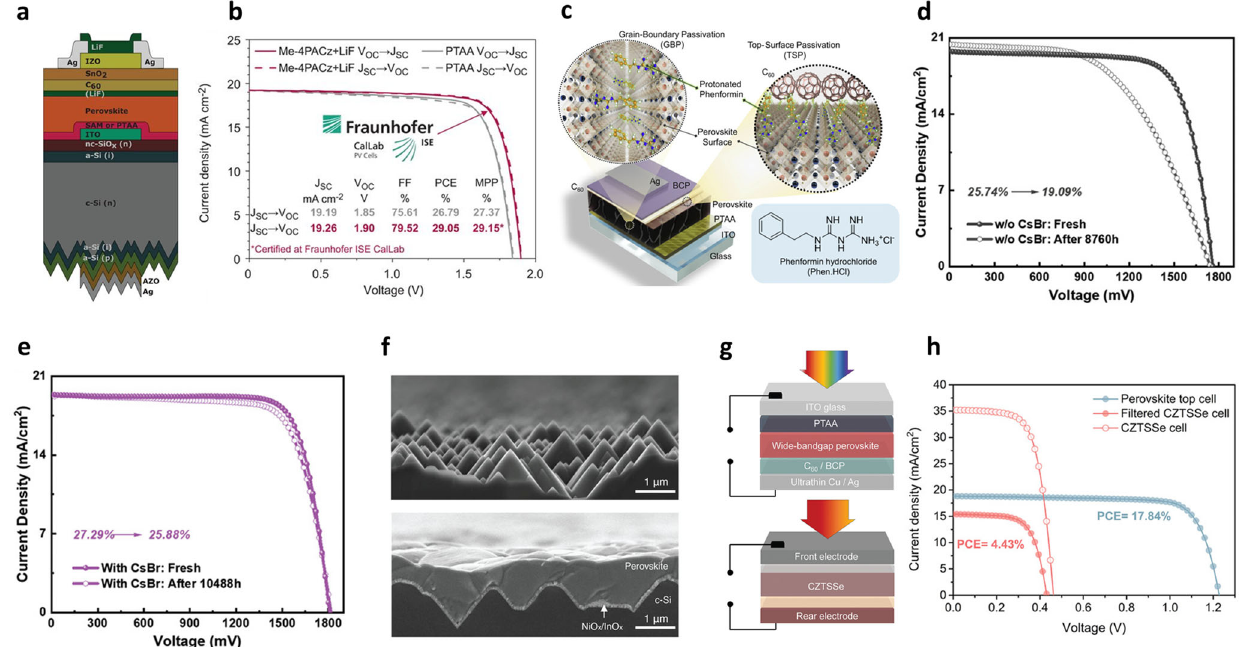
Fig. 4 The development of perovskite/silicon tandem solar cells and other emerging perovskite-based tandem devices. a Schematic illustration for the layered structure of a monolithic perovskite/silicon tandem solar cell. b Certi fi ed J – V curve measured at the Fraunhofer ISE, including the MPP value and the device parameters (red), in comparison to a tandem cell with PTAA (gray) as the HTL measured in-house. a , b adapted with permission from ref. 48 , top surface passivation (TSP) strategies, and the molecular structure of the PhenHCl passivation molecule used in the study. c adapted with permission from ref. 51 , Copyright 2021 Elsevier Inc. d , e Comparison of the original ef fi ciency of the PSTSC device stored in a nitrogen atmosphere ( d ) without CsBr after 8760 h and (e) with CsBr after 10488 h. d , e adapted with permission from ref. 52 , Copyright 2021 Wiley-VCH. f Cross-sectional SEM images of a textured c-Si with an average pyramid size of 2 μ m (top) and corresponding substrates covered by solution-processed perovskite crystals (bottom). f adapted with permission from ref. 53 , Copyright 2020 American Association for the Advancement of Science. g Device architecture of a perovskite/ CZTSSe tandem solar cell. h J – V curves of various types of the sub- and tandem cells based on a perovskite and CZTSSe. g , h adapted with permission from ref. 59 , Copyright 2022